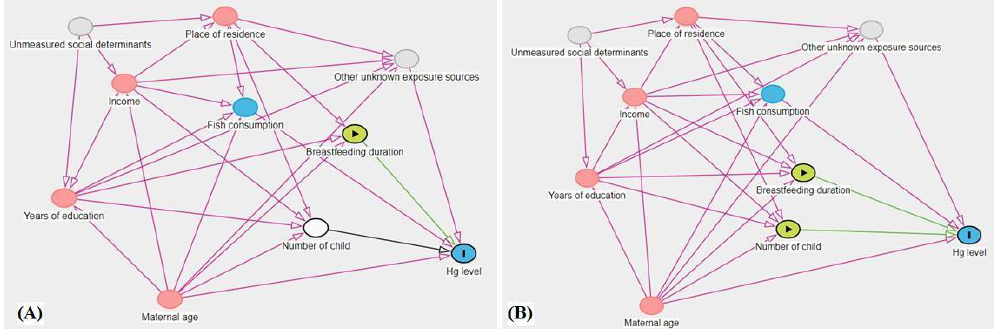
Figure 2. DAG models: ( A ) 6-month period, including only breastfeeding duration as independent variable; ( B ) 2 years and 5 years period, including number of children and breastfeeding duration as independent variables.